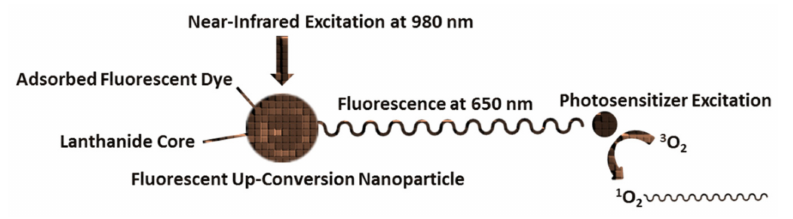
Figure 1. Scheme of UCNP